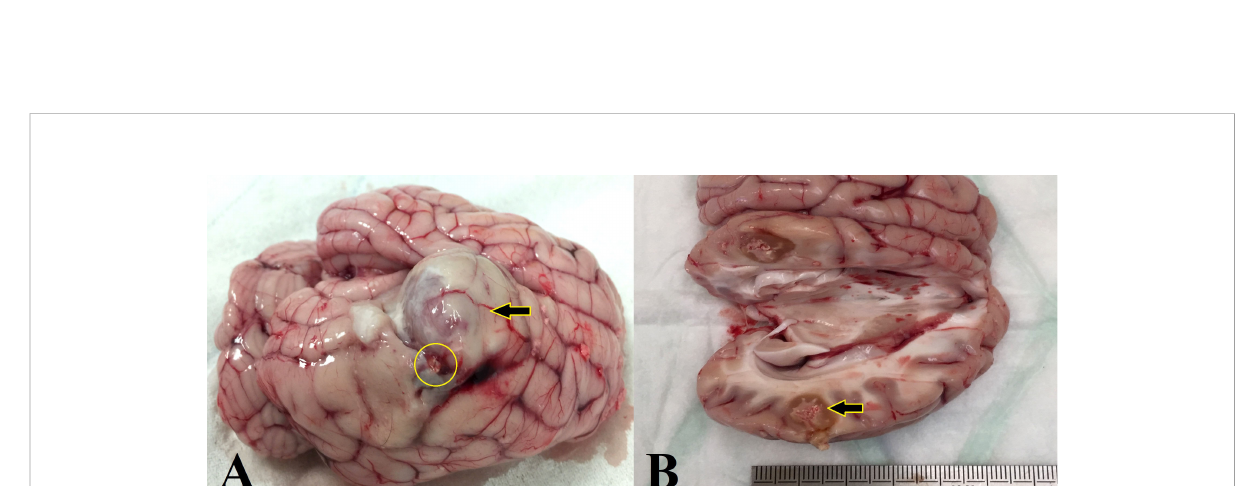
FIGURE 2 Macroscopic aspect of the tumor-bearing brain after the treatment with 166 Ho suspension. (A) Ho injection outside of the GB tumor (yellow circle) for the pig 1, “ positive fail pig ” . Tumor growth continued on the opposite side of the 166 Ho injection area (arrow). (B) Pig of group 1, 166 Ho was injected entirely inside the tumor in the targeted location (arrow). No evidence of hemorrhage due to needle